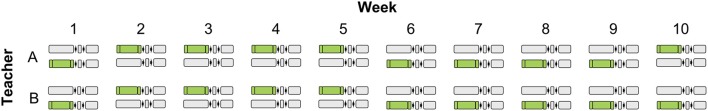
Mini-experiments were replicated over 10 different topics and weeks, for each of two classrooms (and each of five measures). Order of conditions was counterbalanced.